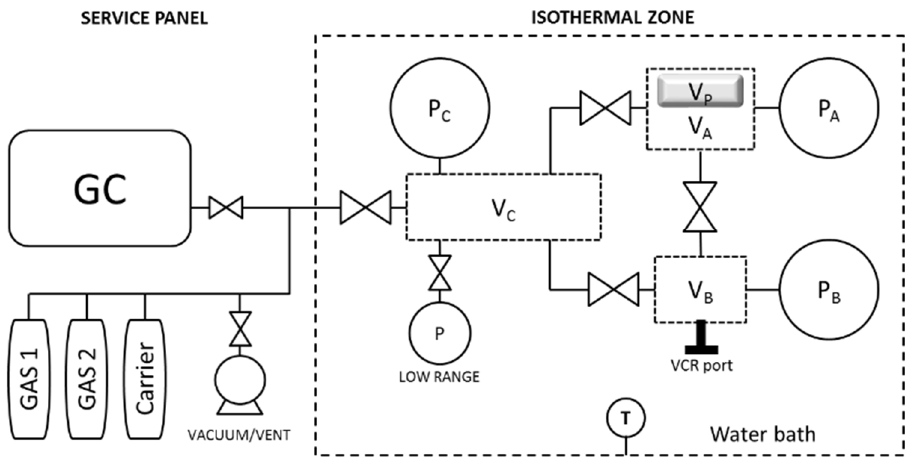
Figure 2. Schematic of the barometric mixed-gas unit used for sorption experiments discussed in this work (adapted from the literature [11]). GC—gas chromatograph.